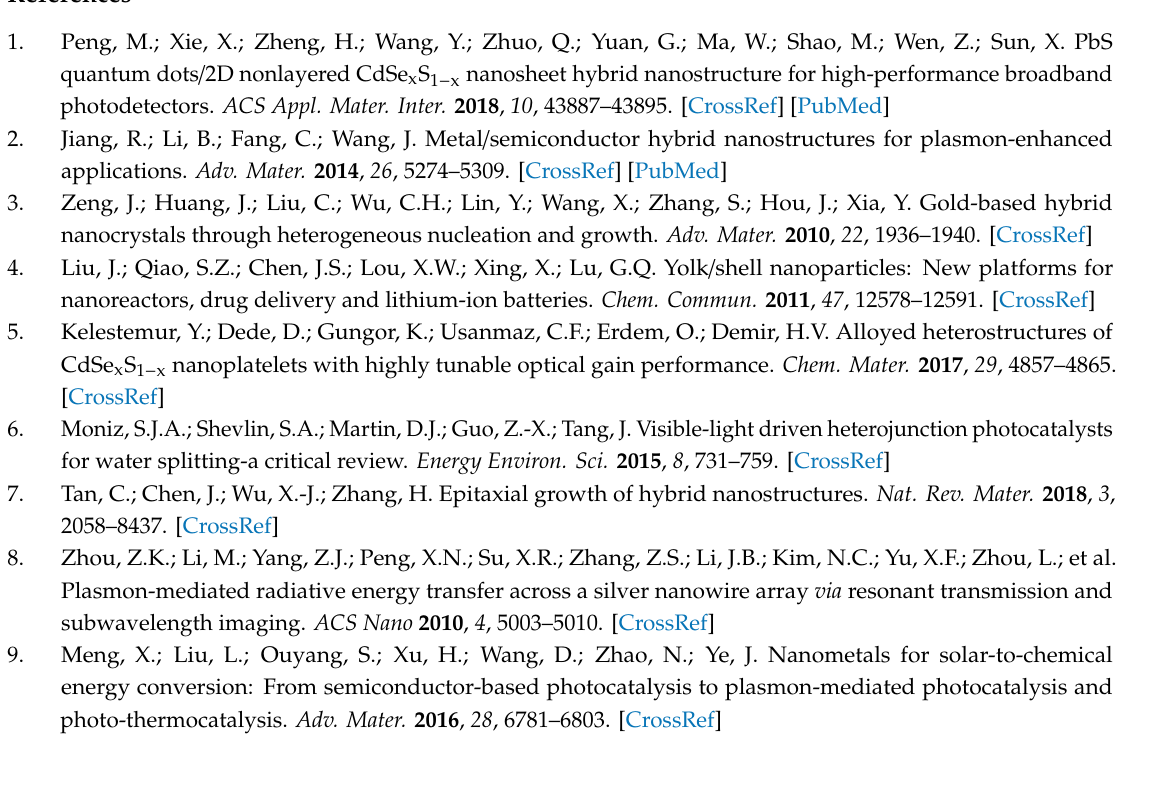
Figure S1: Low magnification TEM images of the products obtained at di ff erent reaction time for synthesis of yolk-shell Au − PbSe NRs, Figure S2: The average shell thicknesses of Au@Se NRs were respectively 4.2 nm and 11.3 nm. When 20 µ L of 0.1 M lead acetate solution was added, the obtained Au-PbSe NRs kept yolk-shell nanostructure, the average thicknesses of PbSe shells were 4.3 nm and 8.5 nm, and the corresponding nanovoid sizes were about 0.4 nm and 4.8 nm respectively, Figure S3: TEM images of ( a ) Au–CdSe NRs, ( b ) Au–Bi 2 Se 3 NRs and ( c ) Au–CuSe NRs. ( d–f ) Corresponding HRTEM images at the ends of hybrid NR, ( g ) EDS spectra of Au-CdSe NRs and AuBi 2 Se 3 NRs, ( h ) XRD patterns of Au–CdSe NRs, Au-Bi 2 Se 3 NRs and Au– CuSe NRs. The standard patterns of hexagonal-phase CdSe (PDF#08-0459), Bi 2 Se 3 (PDF#33-0214) and CuSe (PDF#20-1020)